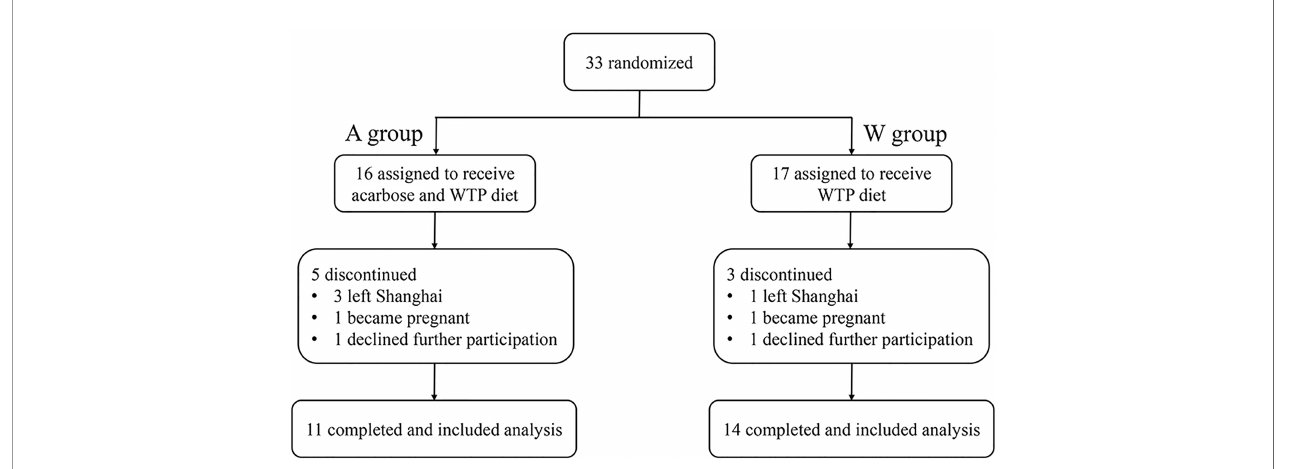
FIGURE 1 | Design and participant fl ow of clinical